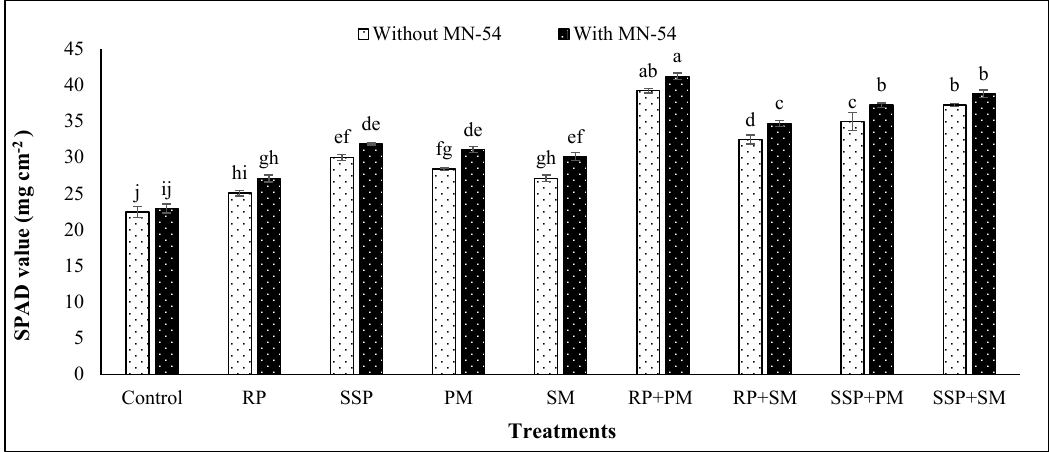
Figure 1. Effect of phosphorus fertilizers, organic manures, and Bacillus sp. MN-54 addition on chlorophyll content (SPAD value) of chickpea measured at 55 d after sowing. Column and error bars represent means and standard errors of triplicate values, respectively. Means having different letters differ significantly according to LSD test at p ≤ 0.05. (MN-54, Bacillus sp. MN-54; RP, rock phosphate; SSP, single super phosphate; PM, processed manure; SM, simple manure).